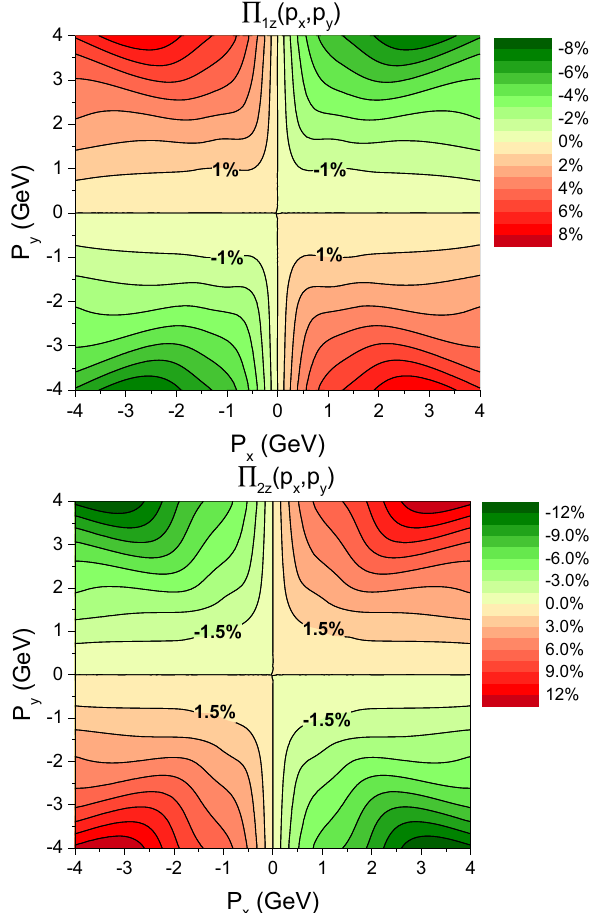
Fig. 4 Thefirsttermoflongitudinalpolarization, Π 1 z ,andsecondterm of longitudinal polarization, Π 2 z , distributed on transverse momentum plane, for Au + Au 200GeV collisions with impact parameter ratio b 0 = 0 . 68 at rapidity bin | y | <